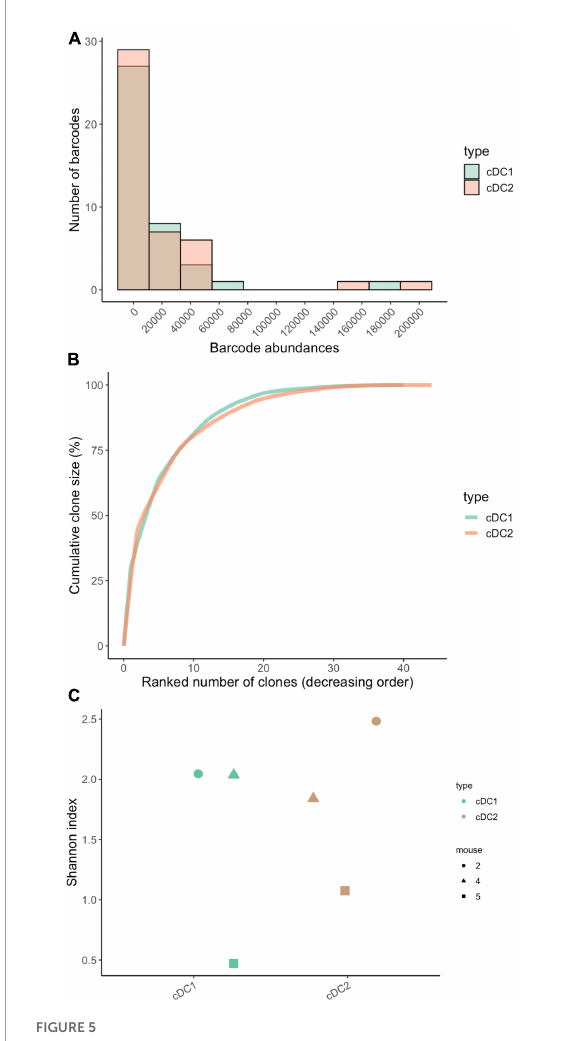
FIGURE5 Clone size distributions and clonal diversity between lung-resident cDC1 and cDC2. (A) Clone size histograms highlight a similar distribution for both subtypes. (B) Cumulative clone size diagram for cDC1 and cDC2. The concave shape highlights a clonal composition made by few relatively big clones with five clones accounting for 60% of the total barcode abundance. (C) Dotplots of the Shannon diversity index within each subtype. Each dot represents a single mouse. No statistical difference was observed between the two subtypes (tested with paired-Wilcoxon test, p -value = 0.7). N = 3 mice for all panels, total of 60 barcodes (m1 = 32 barcodes, m2 = 17 barcodes, m3 = 11